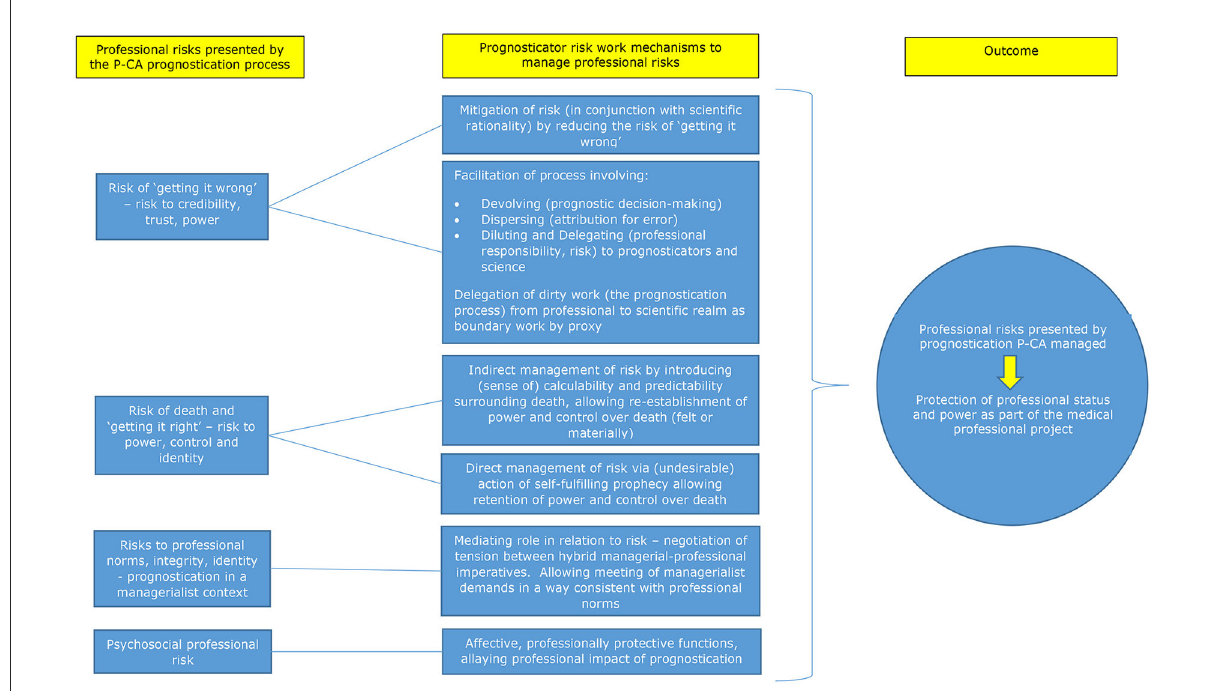
FIGURE1 Theoretical model of the professional risk management functions of prognosticators in the context of prognostication post-cardiac